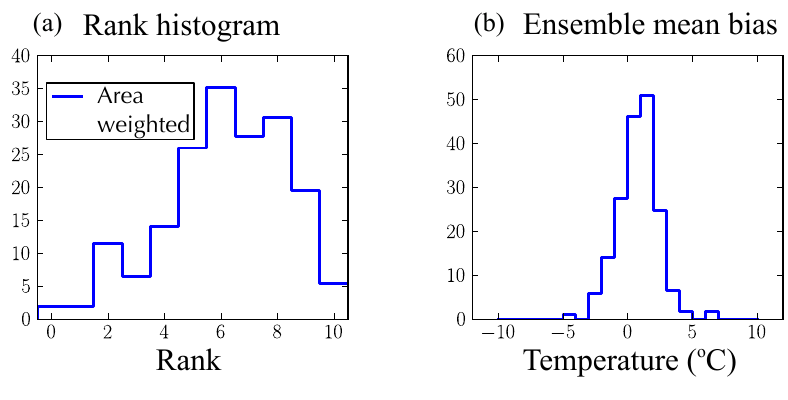
Fig. 5. As in Fig. 3b and c, but the uncertainty in the MARGO data are taken into account in the analysis of the PMIP1 ensemble. (a) Area- weighted rank histogram. High rank indicates that MARGO is warmer at the LGM than the ensemble. (b) Histogram of the difference between the PMIP1 ensemble mean and the MARGO